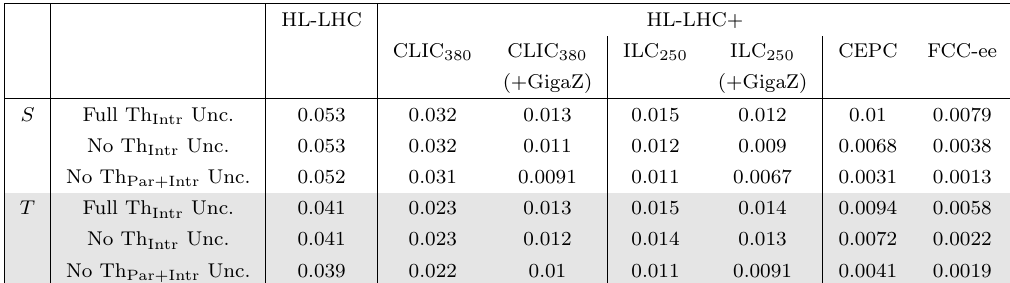
Table 37 . Comparison of the sensitivity at 68% probability to new physics contributions to EWPO in the form of the oblique S and T parameters, under di(cid:11)erent assumptions for the SM theory un- certainties. We express the results in terms of the usually normalised parameters: S = 4 sin 2 (cid:18) w ^ S=(cid:11) and T = ^ T=(cid:11)